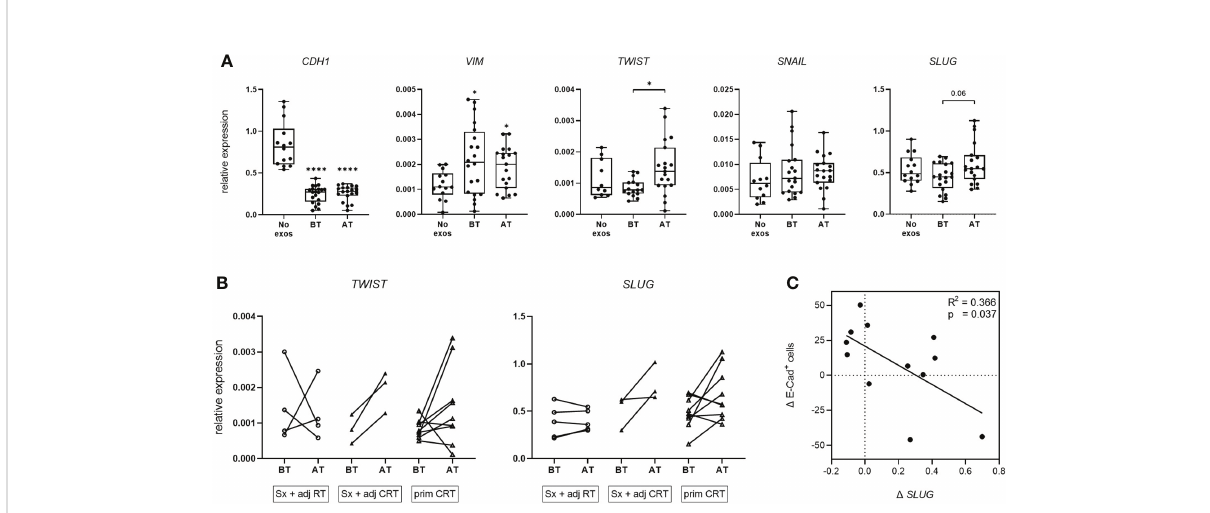
FIGURE 3 mRNA expression of EMT markers and transcription factors of UD-1 cells upon co-incubation with exosomes isolated from plasma of HNSCC patients. (A, B) UD-1 cells were co-incubated with exosomes isolated from plasma of n = 22 HNSCC patients BT and AT. mRNA expression of E-cadherin, vimentin and the transcription factors TWIST , SNAIL and SLUG was analyzed by RT-qPCR and normalized to HPRT using 2 - D Ct algorithm. Target mRNA levels are shown as relative expression to HPRT . As controls, UD-1 cells without exosome treatment (no exos, n = 14) were included. In (A) , results are shown ungrouped and are plotted as box-and-whisker blots representing the median value, the 25th and 75th quartiles and the range. Wilcoxon related samples tests were applied to compare BT and AT. Mann-Whitney test was applied to compare no exos with each BT or AT. * and **** correspond to p ≤ 0.05 and p ≤ 0.0001, respectively. Asterisks above boxes indicate the signi fi cance compared to no exos. In (B) , results are grouped according to therapy and shown as before-after blots. N = 4 HNSCC patients were treated with Sx + adj RT, n = 3 with Sx + adj CRT and n = 9 with prim CRT. (C) Pearson correlation analysis of n = 12 HNSCC patients between the exosome induced change of SLUG mRNA expression ( D SLUG ) and E-cadherin protein expression ( D E-Cad + cells) in UD-1 cells, calculated as the difference between BT and AT (expression AT - expression BT